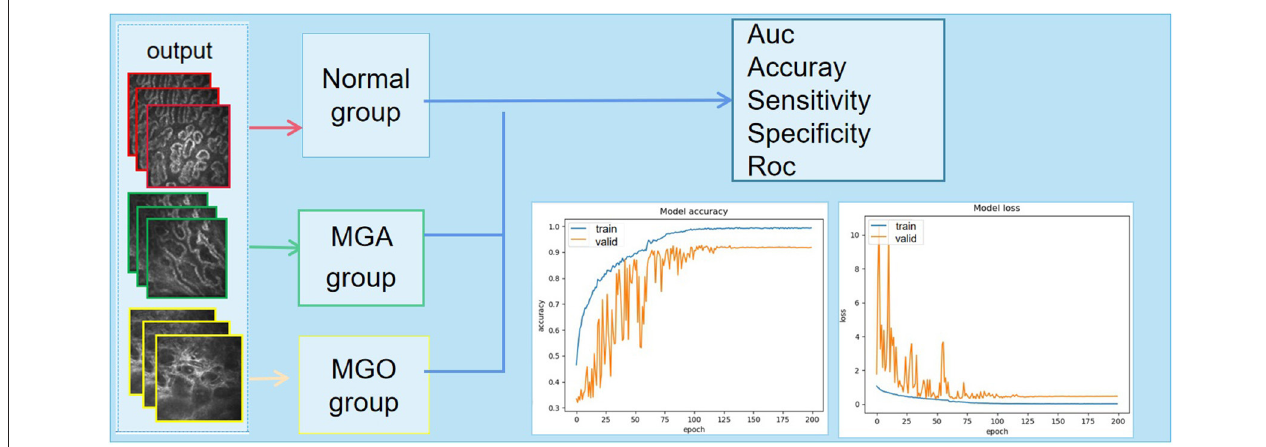
FIGURE 4 | The output of the discriminant result and the final classification accuracy vary with the number of iterations. MGA, atrophic meibomian gland; MGO, obstructive meibomian gland; AUC, area under the curve; ROC, receiver operating characteristic curve.